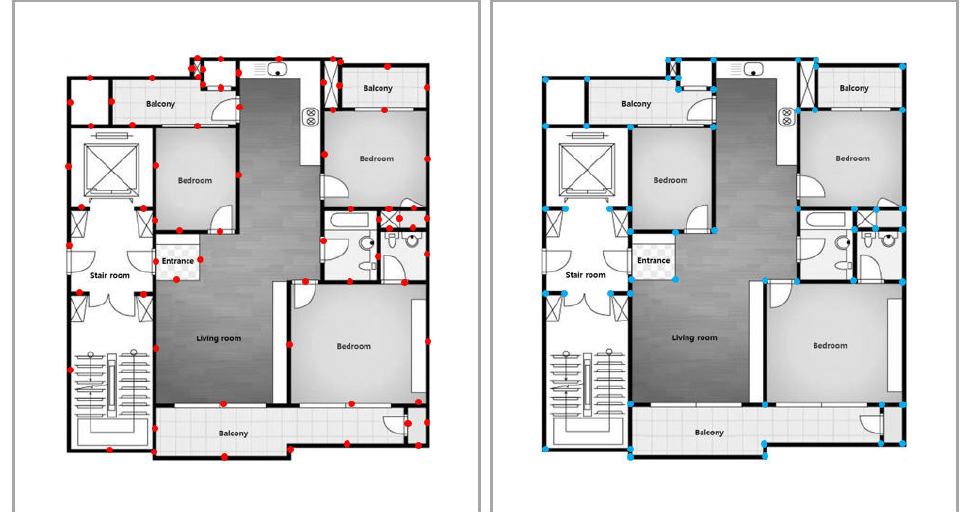
Figure 12. Ground truth wall count: 71 (red dots in the left image), wall junction: 55 (blue dots in the right